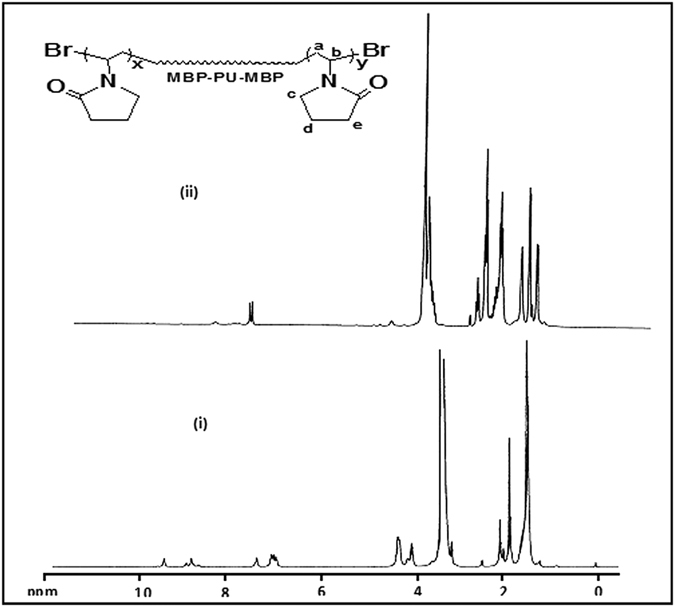
1H-NMR spectra of (a) Br-PU-Br and (b) PNVP-PU-PNVP.